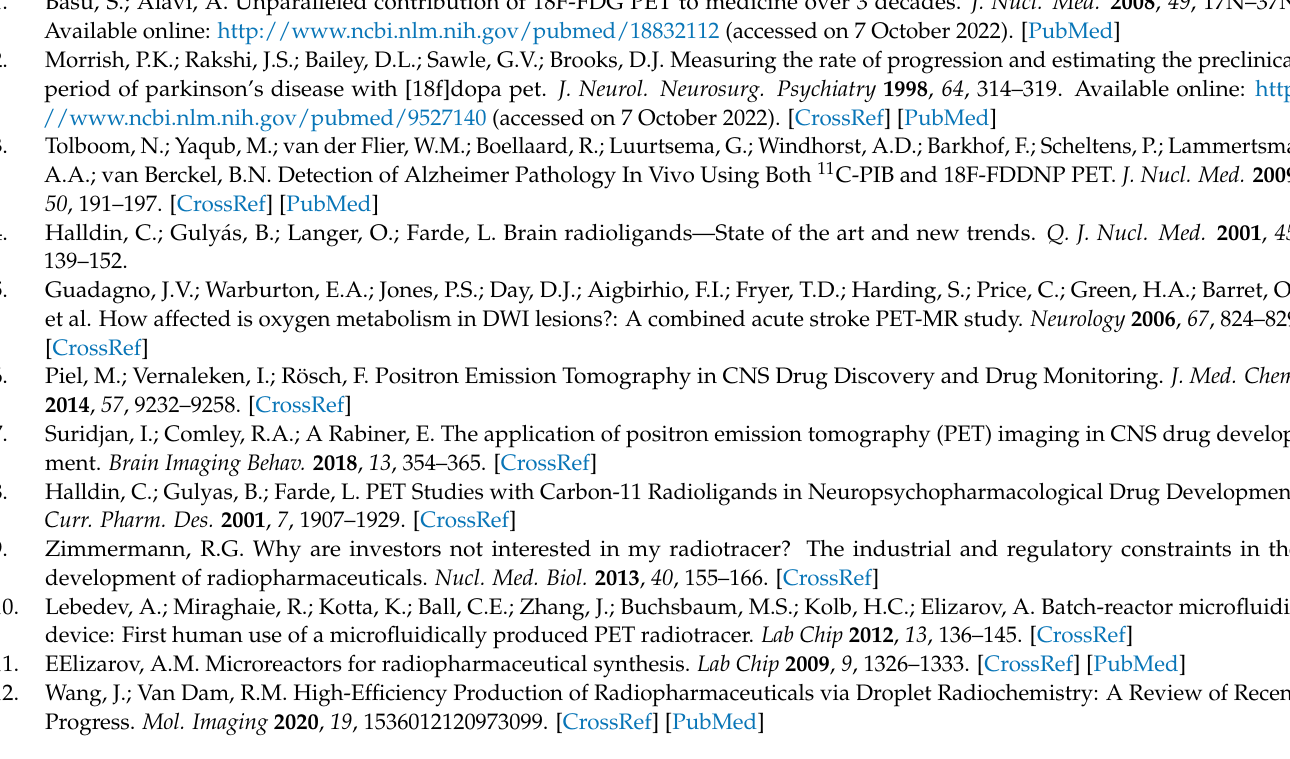
Figure S3: Semi-preparative HPLC injection from the vial B; Figure S4: Semi-preparative HPLC purification (product collection) from the RV2 loop (position B); Figure S5: Pushing the product from the loop RV2 (position A) to the vial H in the iMiDEV™ cassette; Figure S6: Flow chart of the synthesis steps performed on a microfluidic